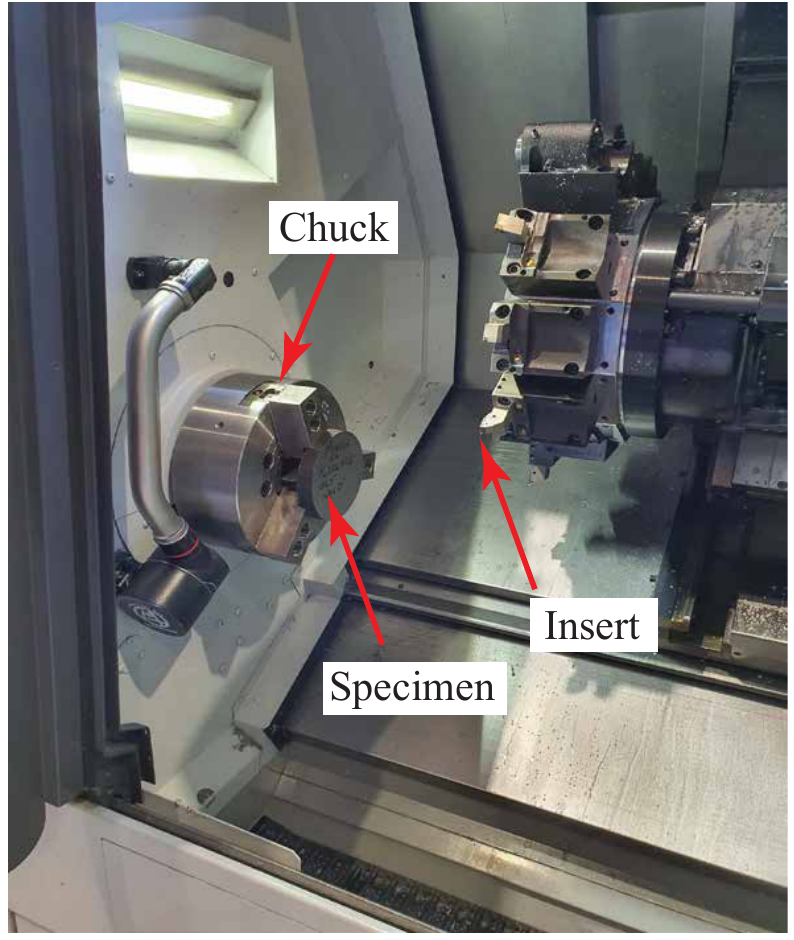
Figure 6. Metal specimen in CNC